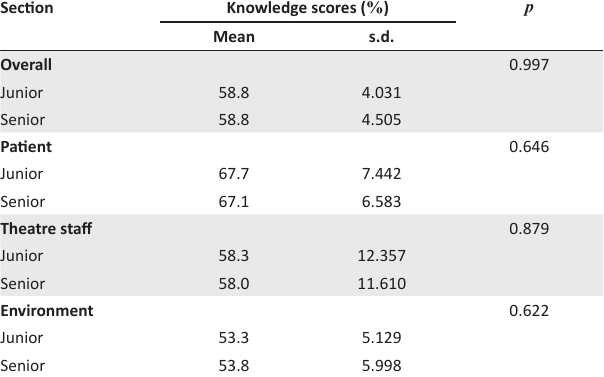
TABLE 3: Comparison between junior and senior anaesthetist knowledge. Section